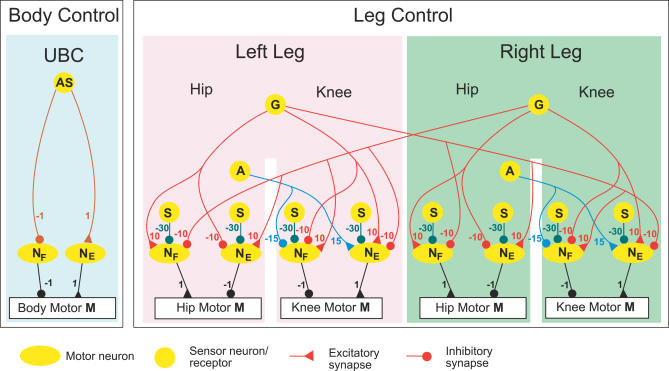
The Reflexive Neuronal NetworkIt consists of two distributed neural modules for leg and body control. The connection strengths (color lines) are indicated by the small numbers. A refers to the stretch receptors for AEA of the hips and G to the ground contact sensor neurons of the feet. NF(NE) refers to flexor (extensor) motor neuron of the body and leg. S represents the angle sensor neurons of each joint. The AS neuron is used to trigger the UBC reflex.